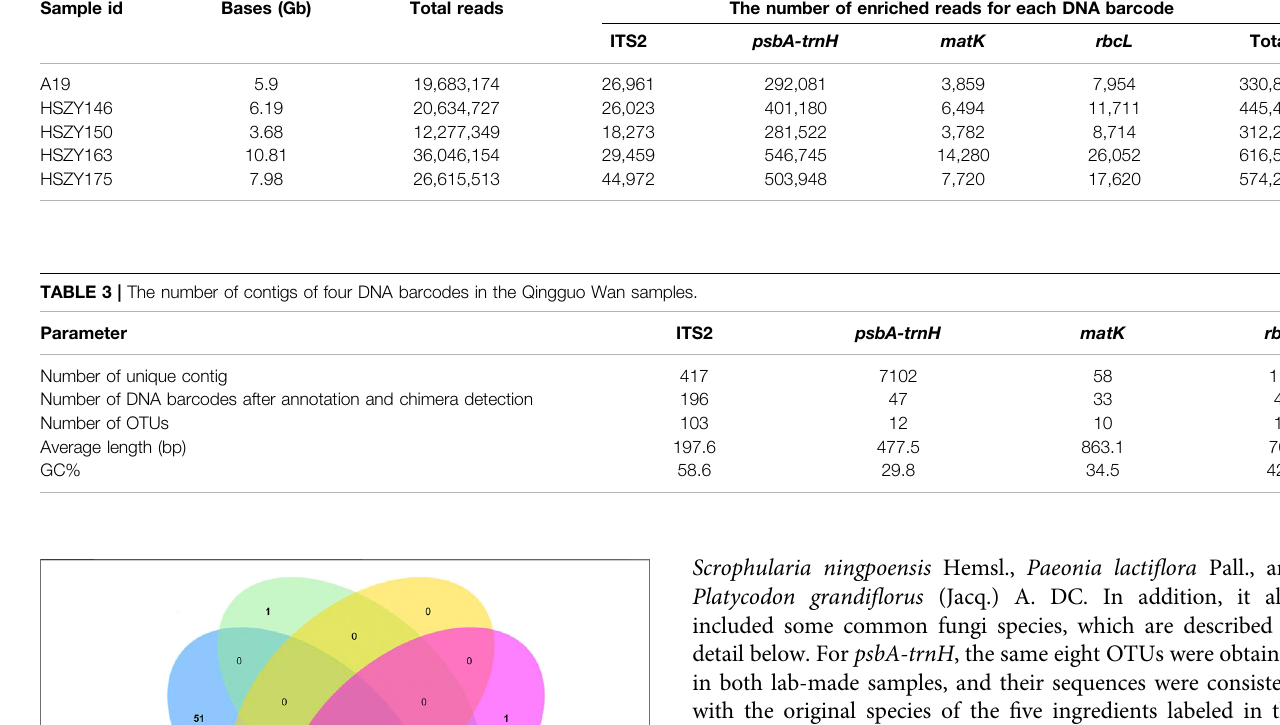
TABLE 2 | A summary of the high-throughput sequencing data and the number of reads enriched for ITS2, psbA-trnH , matK, and rbcL . Sample id